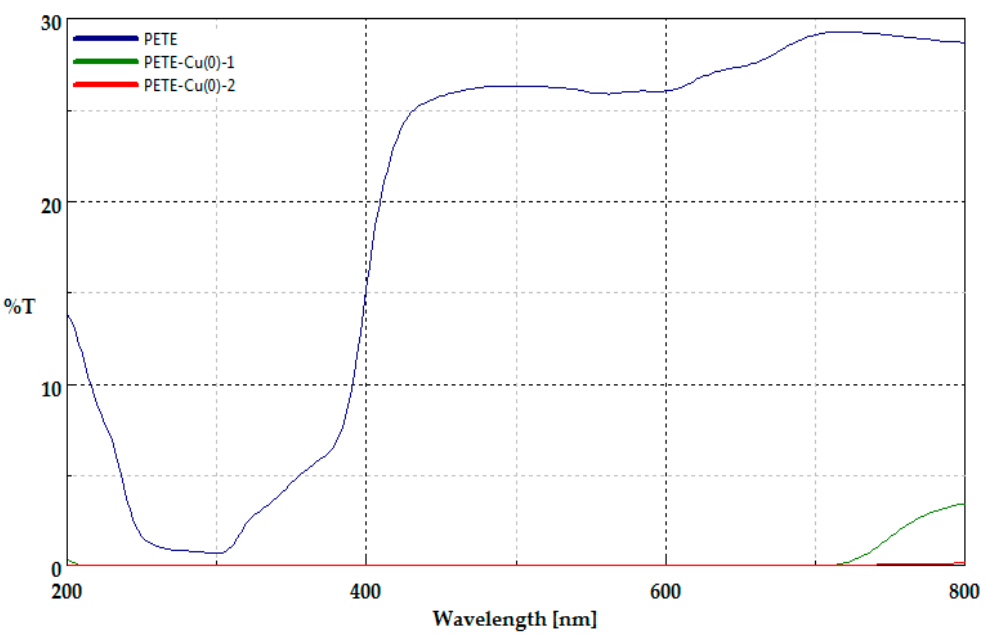
Figure 6. Comparison of transmittance spectra [%T] in the range λ = 200–800 nm of unmodified PETE knitted textile and PETE-Cu (0) composites (PETE-Cu (0) -1, PETE-Cu (0) -2).